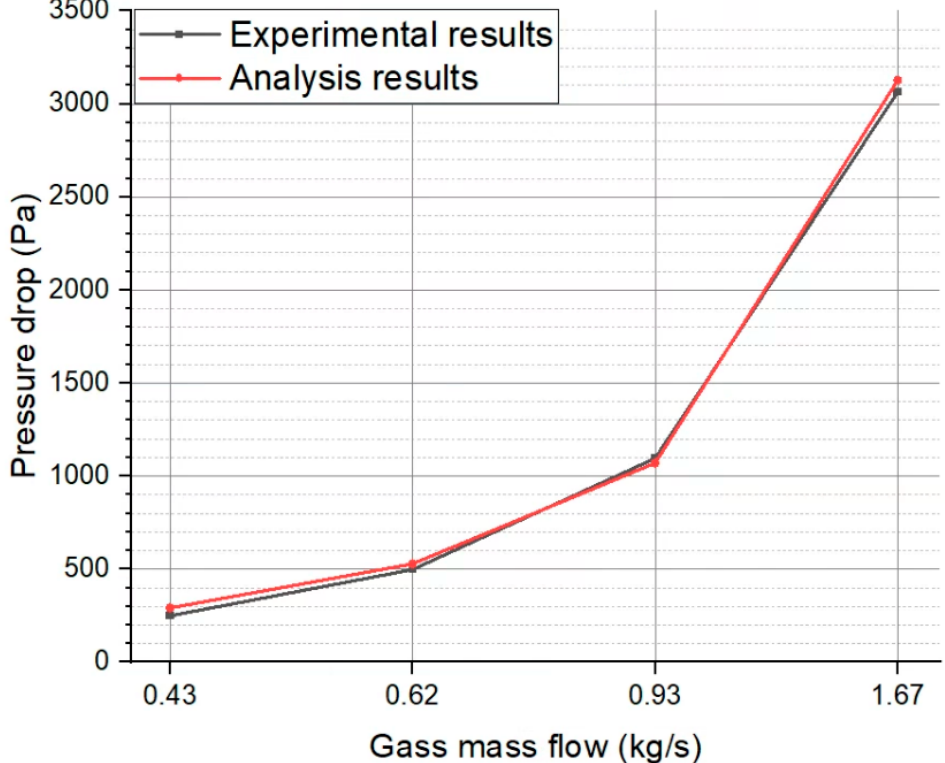
Figure 5. Comparison of experimental and analysis pressure drop results.